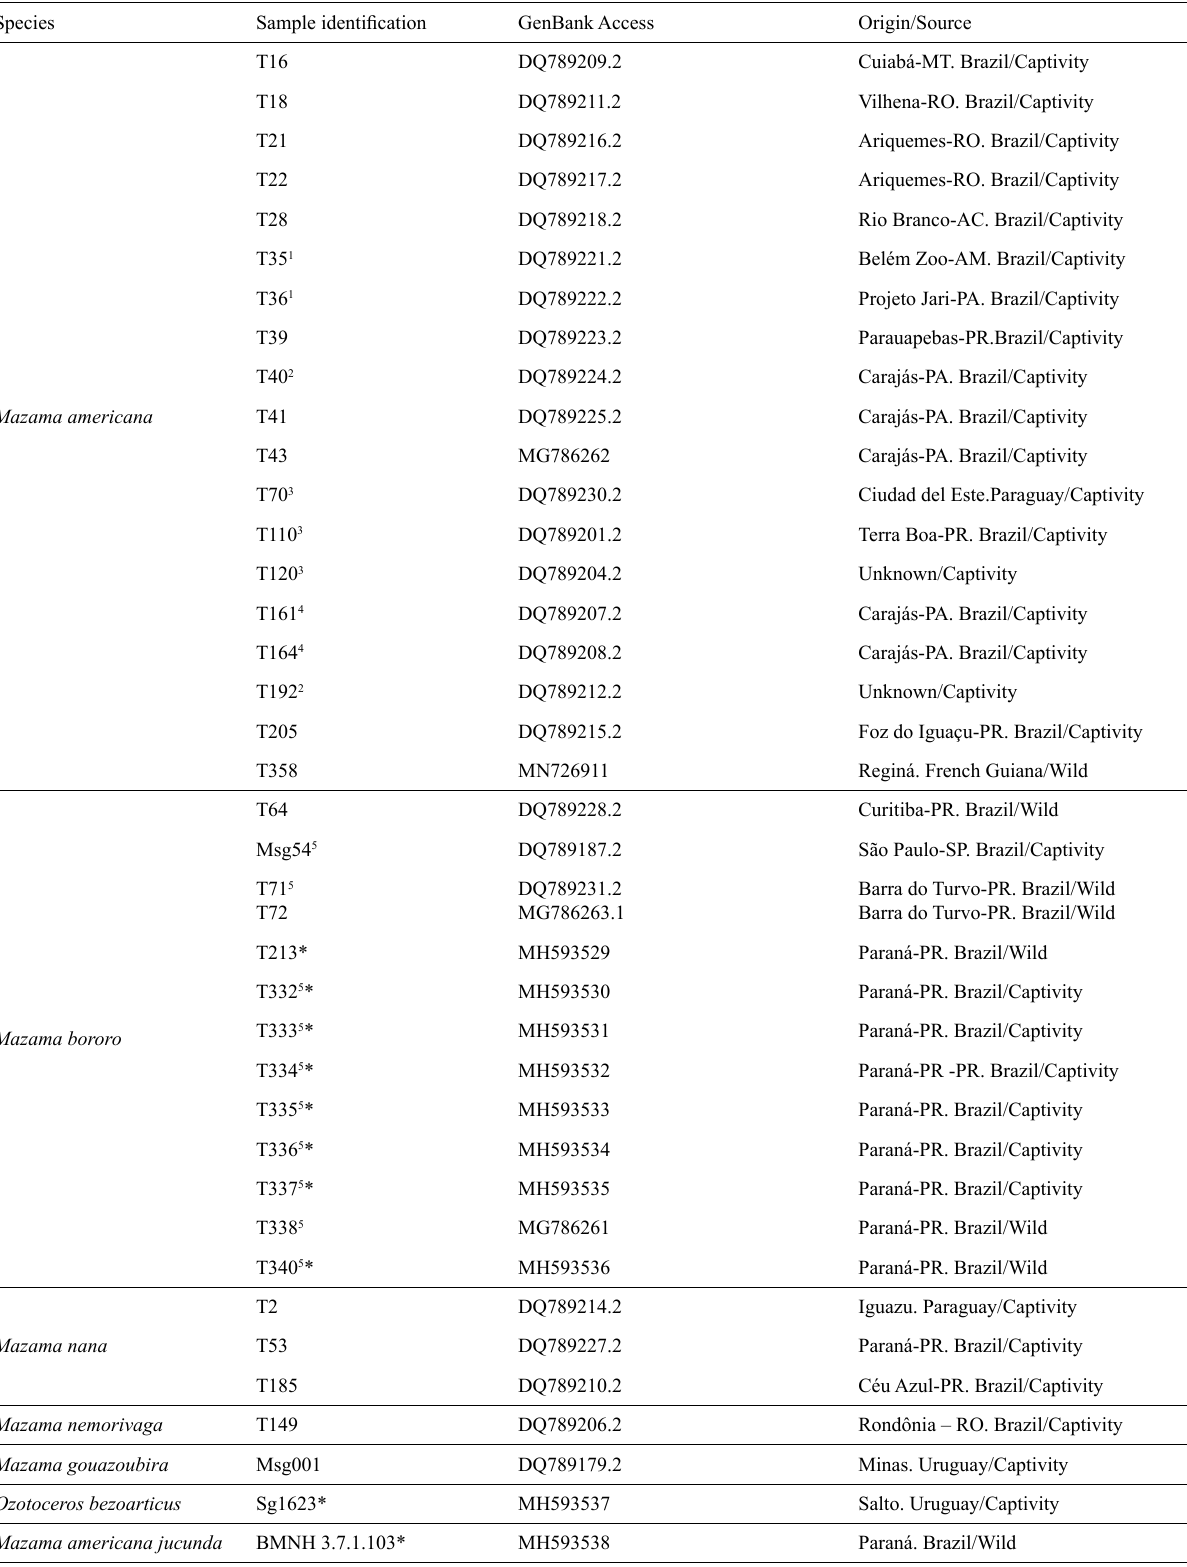
Table 1 – Mitochondrial cytochrome b sequences used for phylogenetic inference among several Mazama specimens.